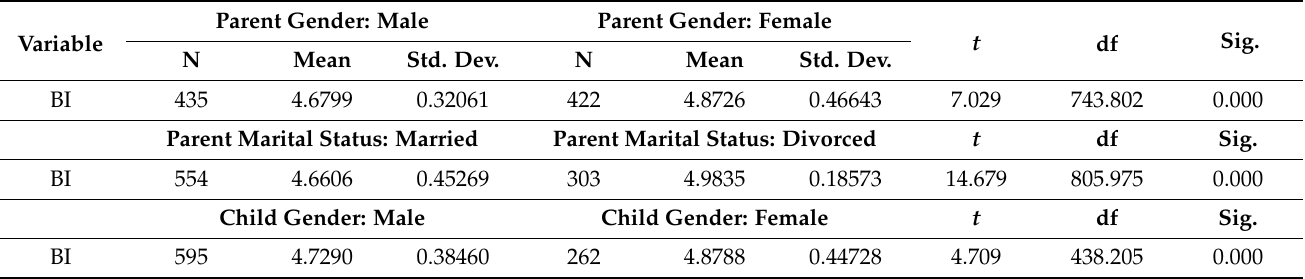
Table 8. t -test of the respondent Behavioral Intention (BI) attributed to parent gender, parent marital status, and child